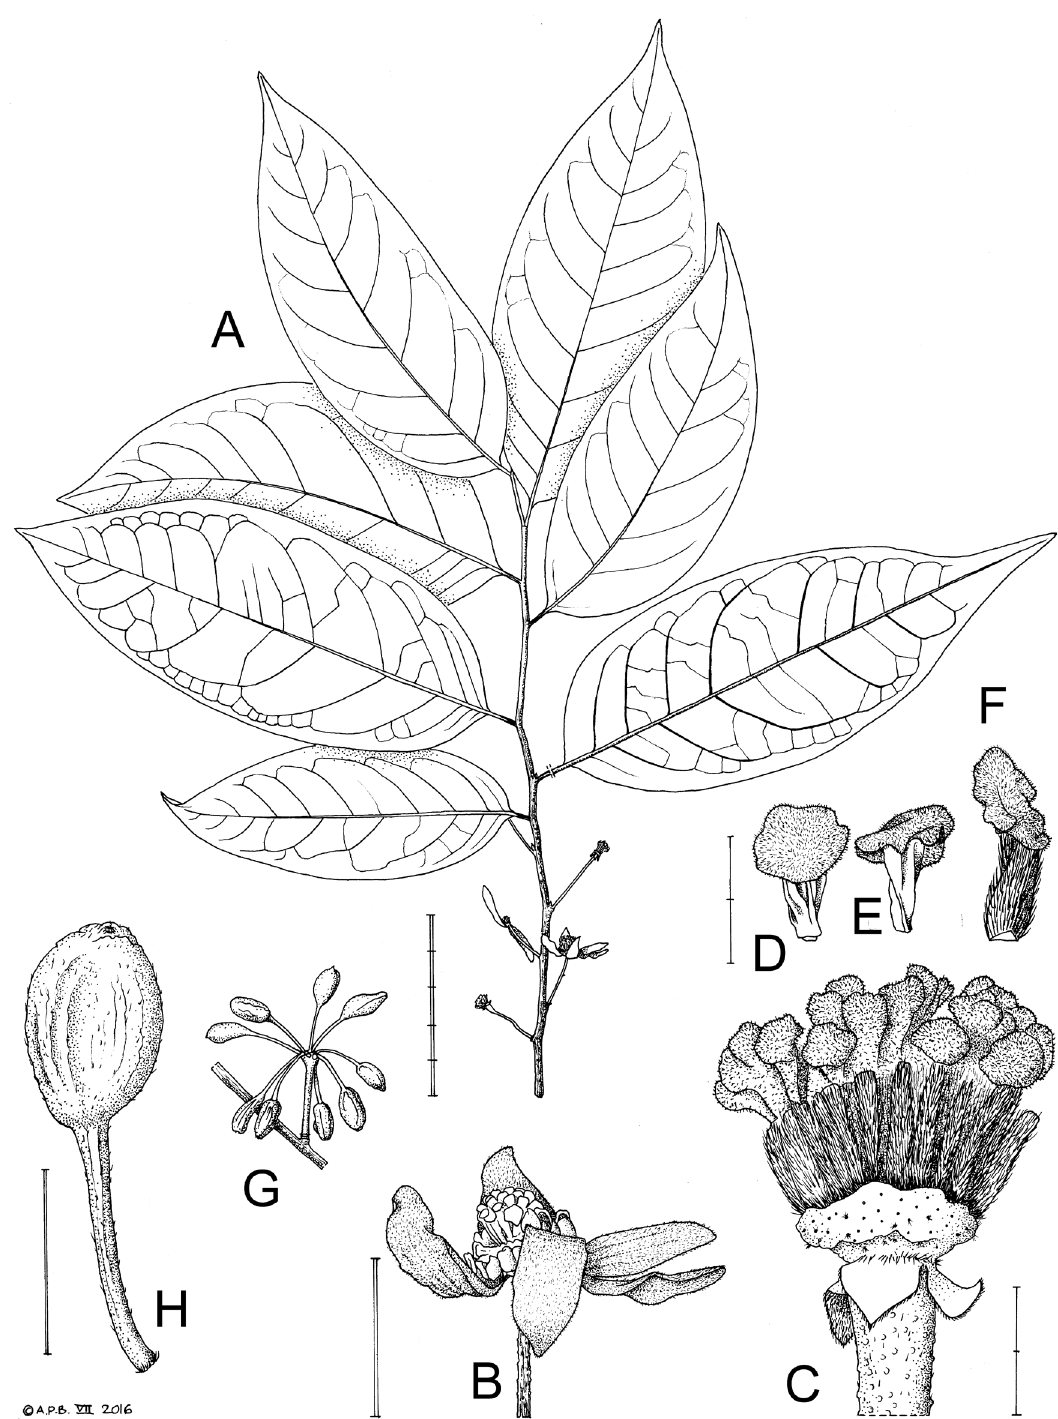
Fig. 7. Huberantha whistleri I.M.Turner & Utteridge sp. nov. A . Flowering shoot (lower right leaf showing abaxial surface, rest adaxial). B . Flower lateral view (one petal missing). C . Remnant flower with carpels and persistent calyx after loss of corolla and stamens. D , E . Two views of stamen. F . Ovary and stigma. G . Fruit (same scale as A). H . Monocarp (immature). Scale bars: graduated single bar = 2 mm; double bar = 1 cm; graduated double bar = 5 cm. Drawn from Whistler 576 . Drawn by Andrew